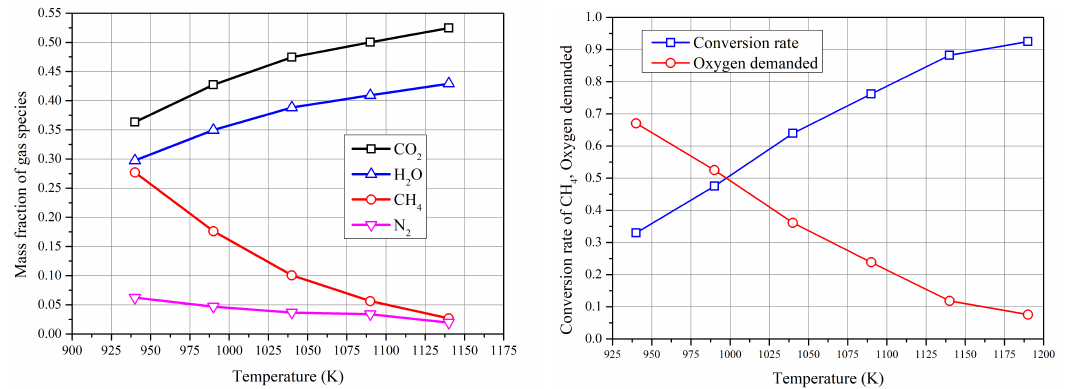
Figure 11. Effect of temperature on the performance of system. Left : gaseous mass fraction at FR outlet. Right : Conversion rate of methane and outlet rate of fuel